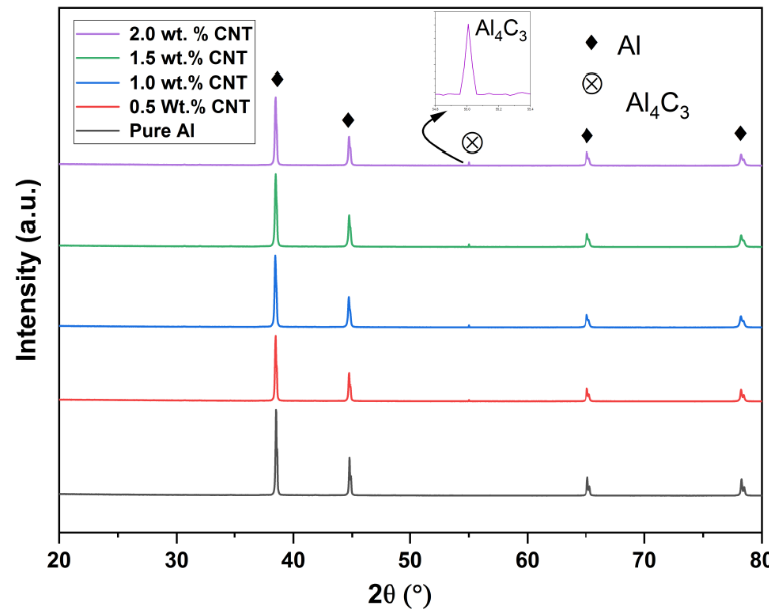
Figure 7. XRD scan of Al-CNT-Sn composites with different CNT fraction.